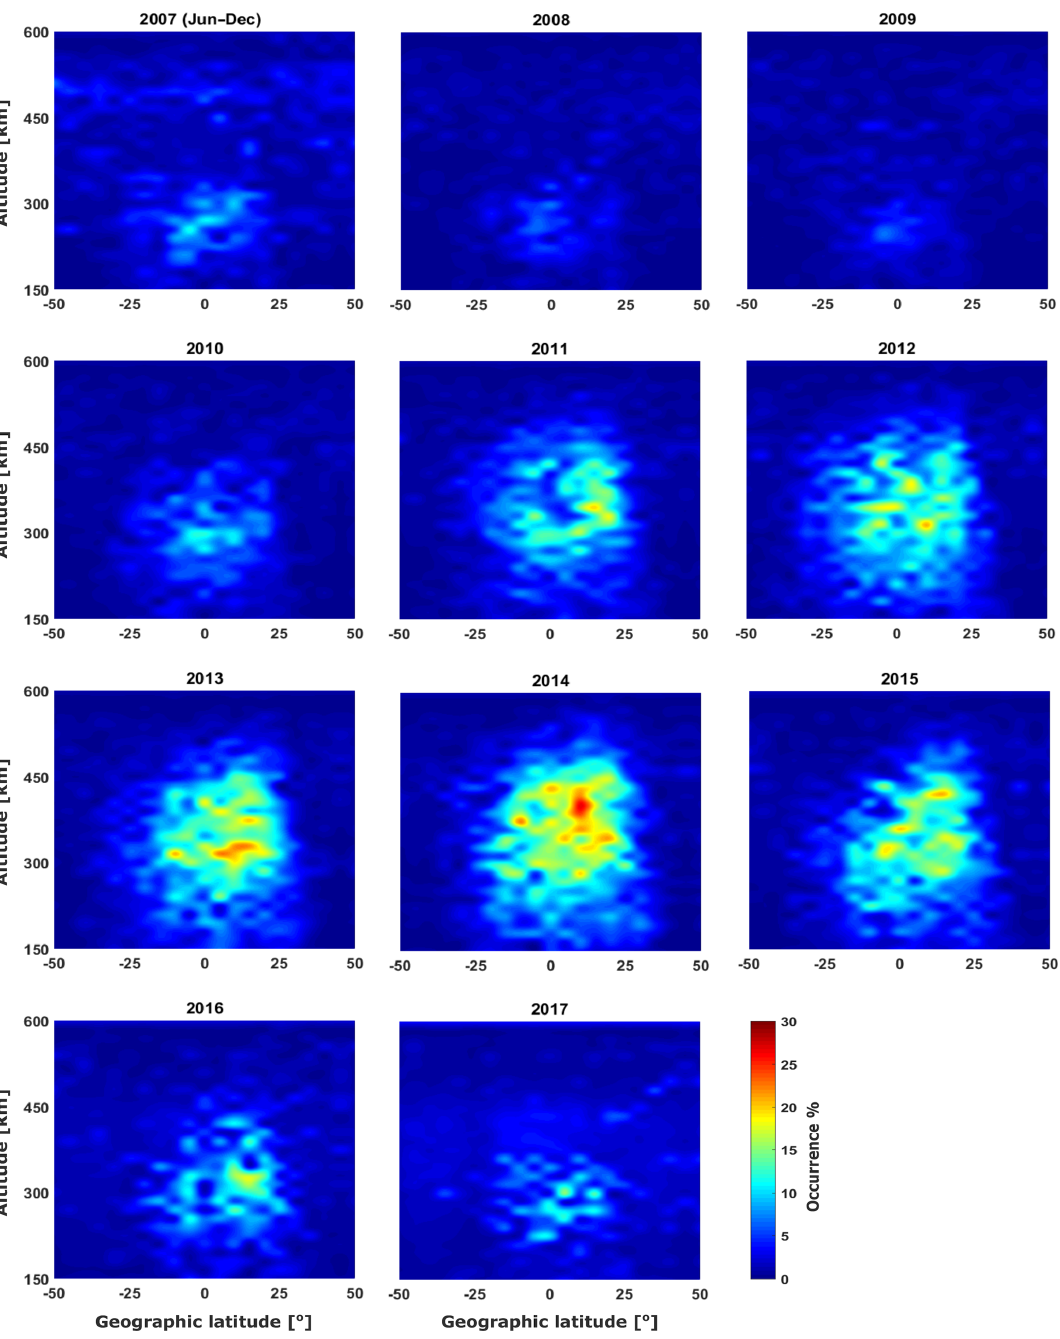
Figure 7. Vertical distribution of equatorial plasma bubbles in 5 ◦ latitude by 20km altitude grid during the years between mid-2007 and